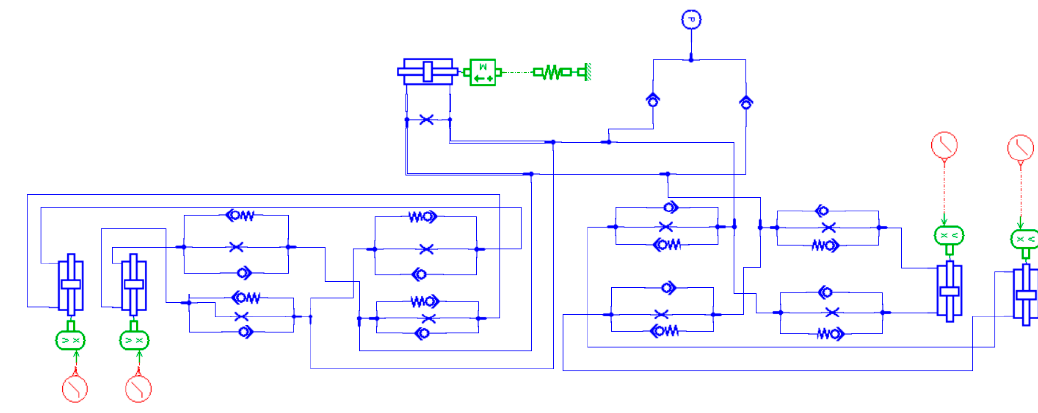
Figure 4. AMESim hydraulic simulation model.